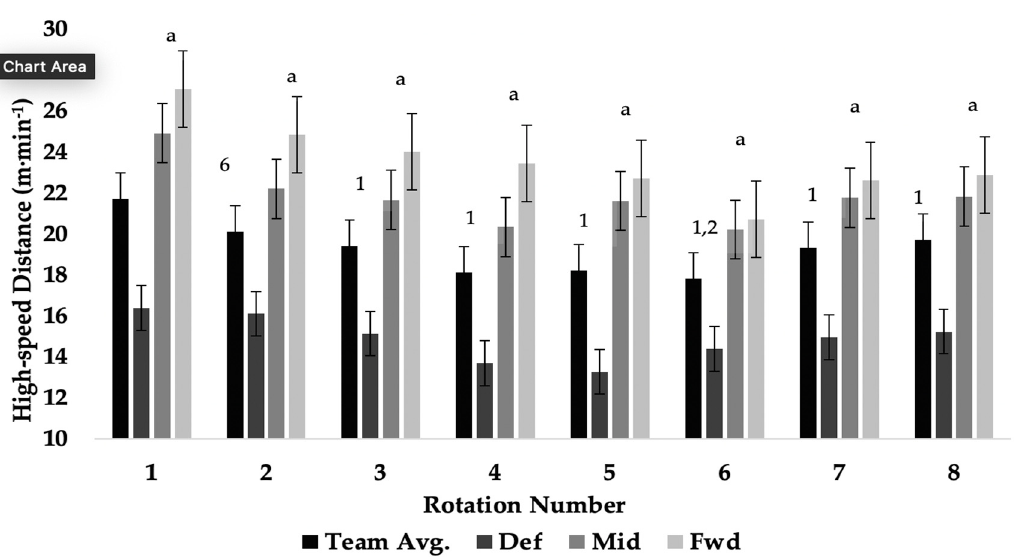
Figure 2. The average relative high-speed distance m · min − 1 of elite female field hockey players across each rotational period during competitive match-play. The letters a, b, c signify the positional variation between the defenders ( a ), midfield ( b ) and forwards, while 1, 2, 3, 4, 5, 6, 7, 8 represent the significant difference across each rotation when compared to each other. Appl. Sci. 2021 , 11 , x FOR PEER REVIEW